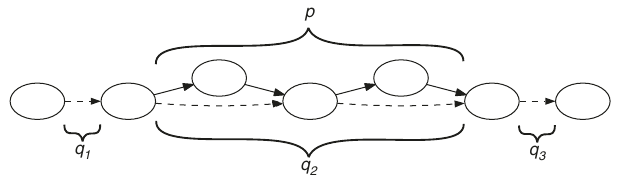
Fig. 5 An example of computing the score of a walk p (solid) relative to a carrying path p a = q 1 q 2 q 3 (dashed). The path p forms a chain with the subpath q 2 of p a , while subpaths q 1 and q 3 form hanging ends. We count the length of p and subtract lengths of the hanging ends. Thus, the score f ( p p ) = 4 − (1 + 1) 2 = a ,